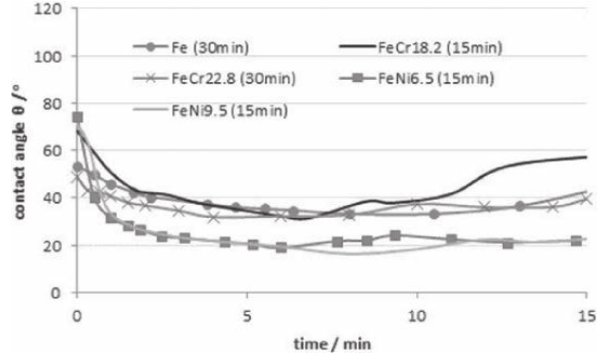
Fig. 3: Contact angle vs. time for type A experiments [19]